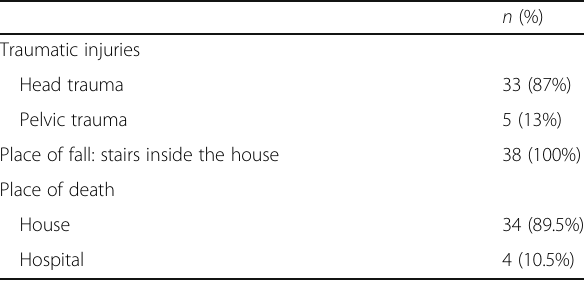
Table 4 Distribution of falls circumstances